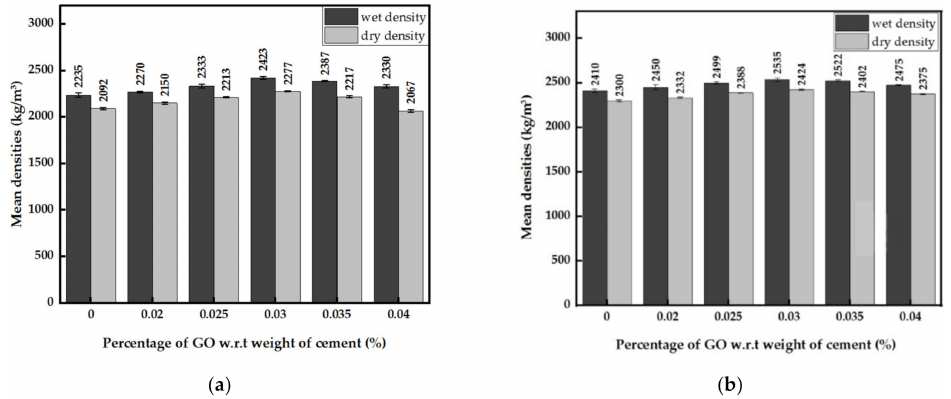
Figure 6. ( a ) Wet and dry densities of cement mortar with GO paste; ( b ) Wet and dry densities of cement mortar with GO